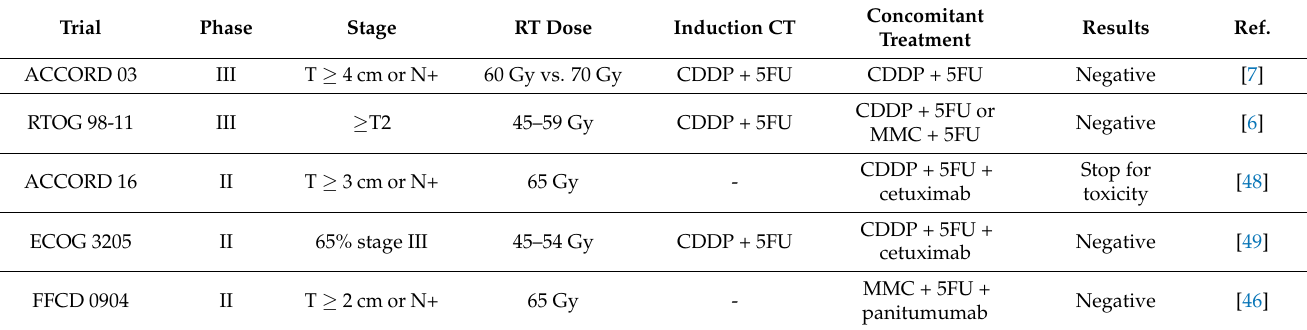
Table 2. Clinical trials in locally advanced